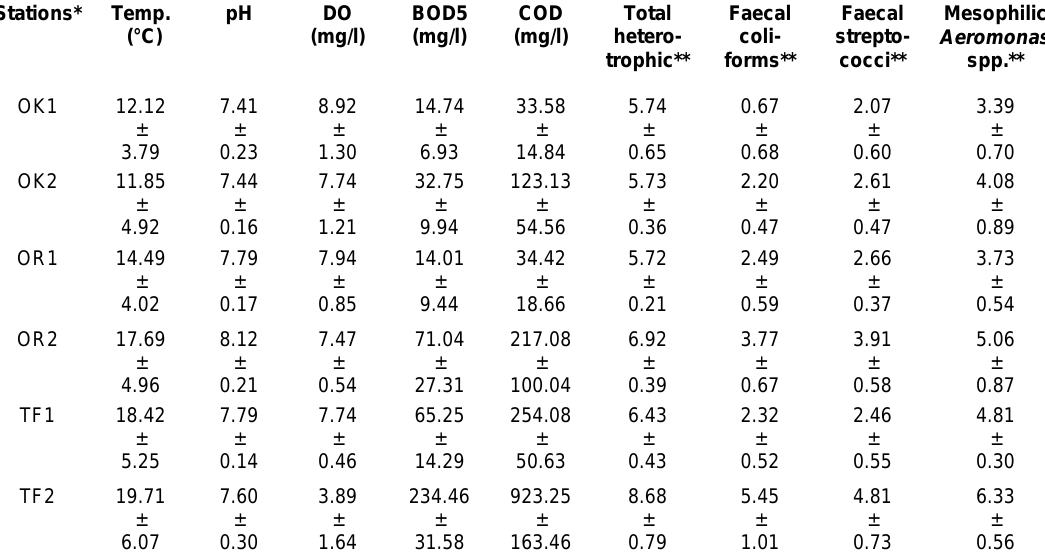
Mean ± Standard Deviation Values of Physical, Chemical, and Bacteriological Data of 24 Riverine Water Samples at Each Station